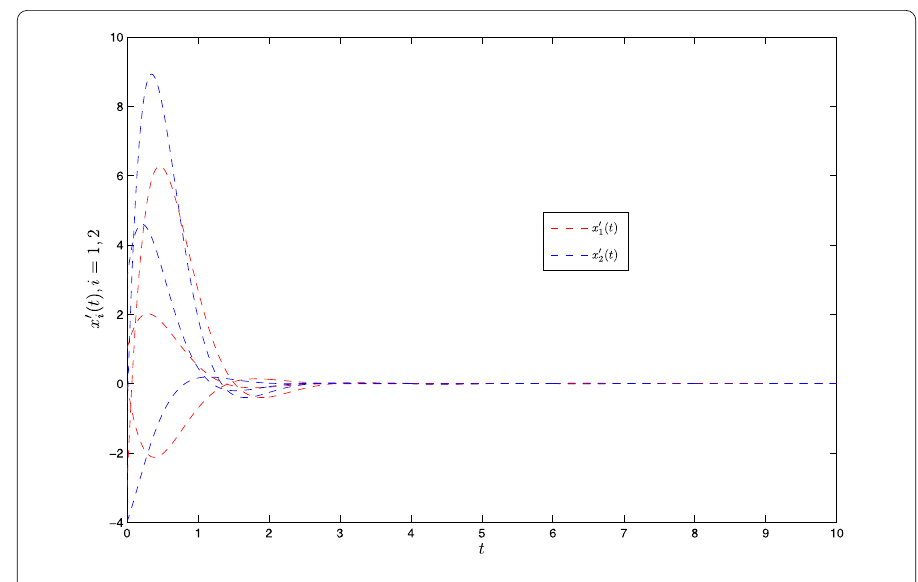
Figure 4 Numerical solutions x (cid:2) ( t ) on system (3.2). Numerical solutions x (cid:2) ( t ) to example (3.2) with initial values: (sin t + 1,–cos t – 3,cos t ,sin t ),(2cos t + 2,3sin t – 1,–2sin t ,3cos t ),(–3sin t – 2,–4sin t + 3,–3cos t ,–4cos t